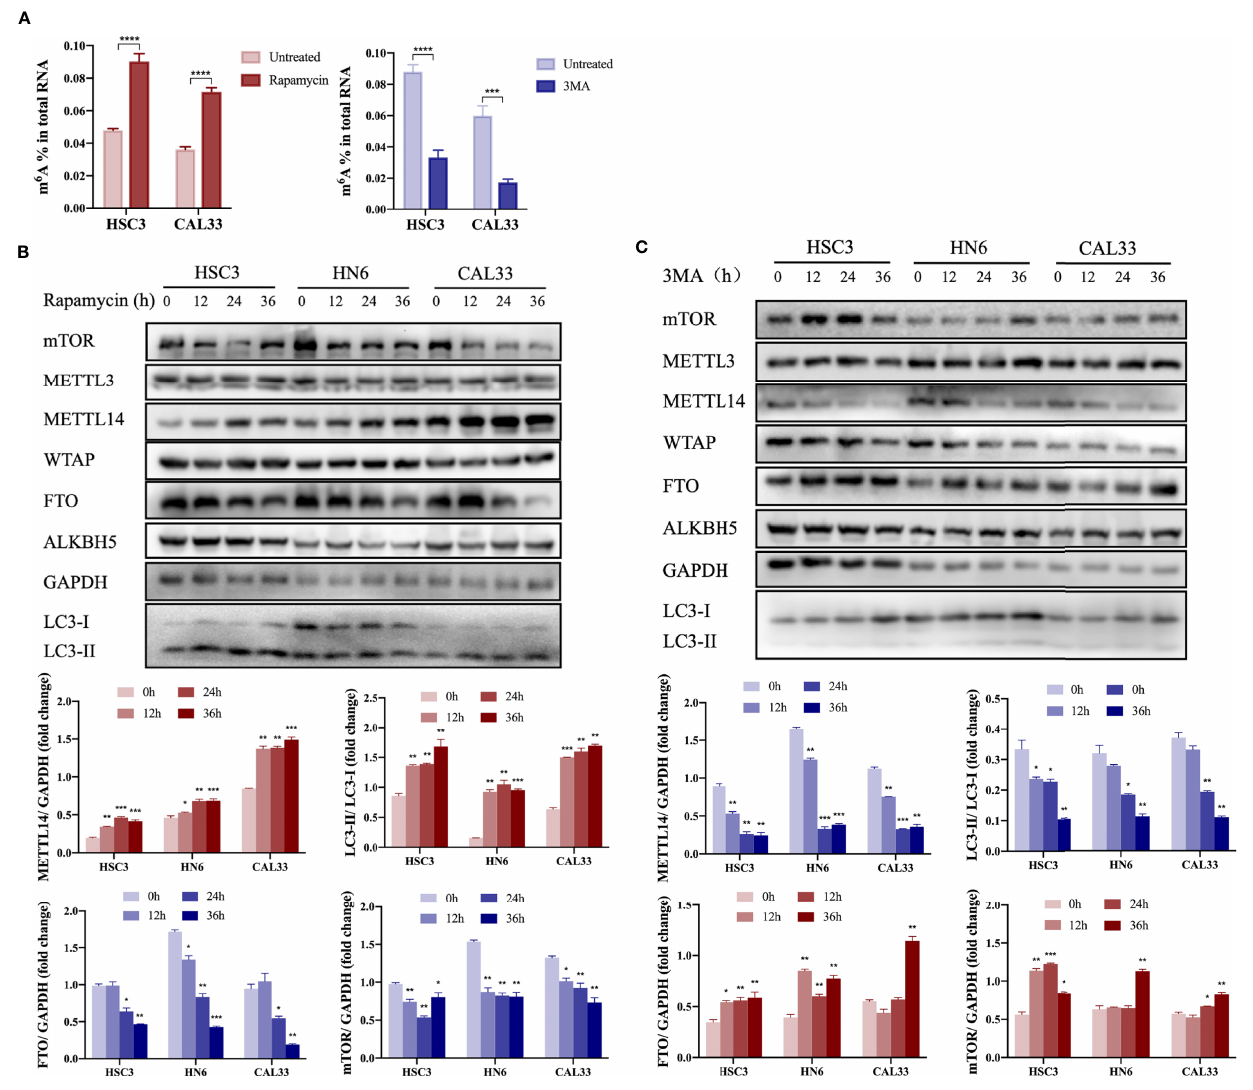
FIGURE 1 | Autophagy activation promoted upregulation of METTL14 expression in OSCC cells. (A) In the autophagy cell model induced by rapamycin (100 nM rapamycin for three days) or inhibited by 3MA (10 mM 3MA for 24 h), the m 6 A level in OSCC cells was determined using an m 6 A RNA methylation quanti fi cation kit (Student ’ s t -test). (B) HSC3, HN6, and CAL33 cells were exposed to 100 nM rapamycin for 0, 12, 24, and 36 h to induce autophagy. Thereafter, mTOR, METTL3, METTL14, WTAP, FTO, ALKBH5, LC3-I, and LC3-II expression levels were determined using western blot (Student ’ s t -test). (C) HSC3, HN6, and CAL33 cells were exposed to 10 mM 3MA for 0, 12, 24, and 36 h to inhibit autophagy. Thereafter, mTOR, METTL3, METTL14, WTAP, FTO, ALKBH5, LC3-I, and LC3-II expression levels were determined using western blot (Student ’ s t -test). ( p or adjusted- p *< 0.05, **< 0.01, ***< 0.001, ****<